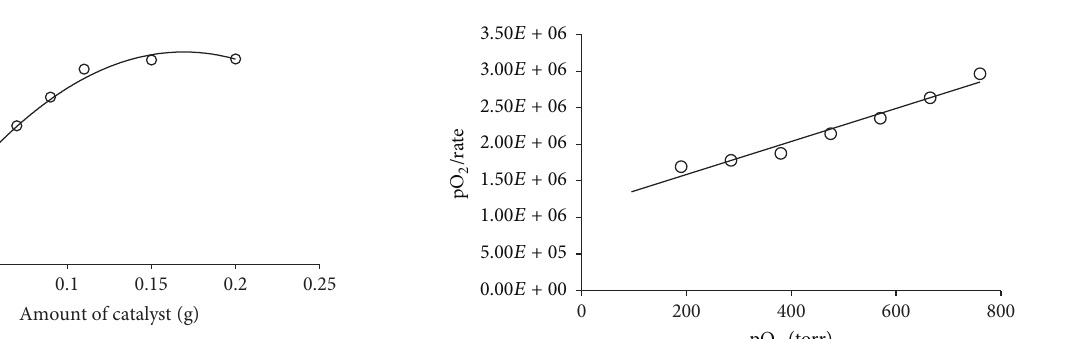
Figure 8: Effect on percent conversion of cyclohexanol to cyclo- hexanone by loading different amount of the catalyst. Reaction